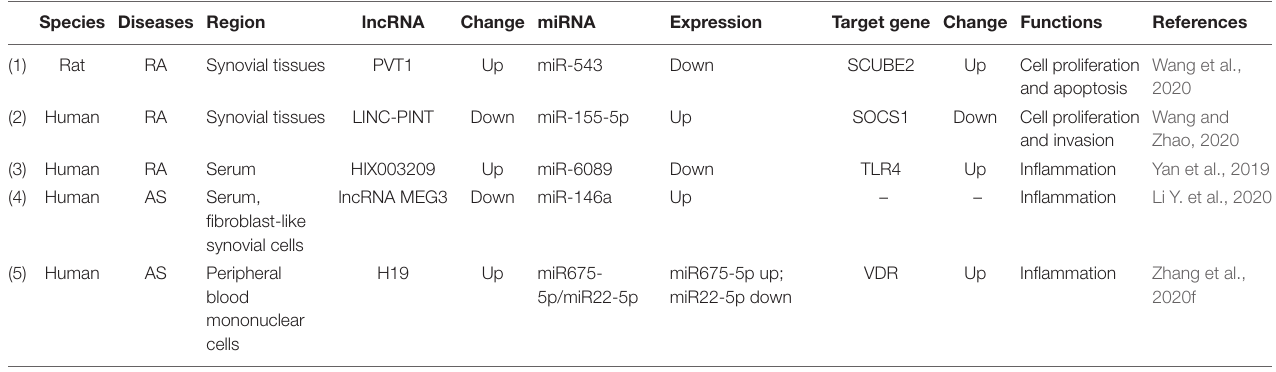
TABLE 2 | lncRNA/miRNA/mRNA networks in rheumatoid arthritis and ankylosing spondylitis. Species Diseases Region lncRNA Change miRNA Expression Target gene Change Functions